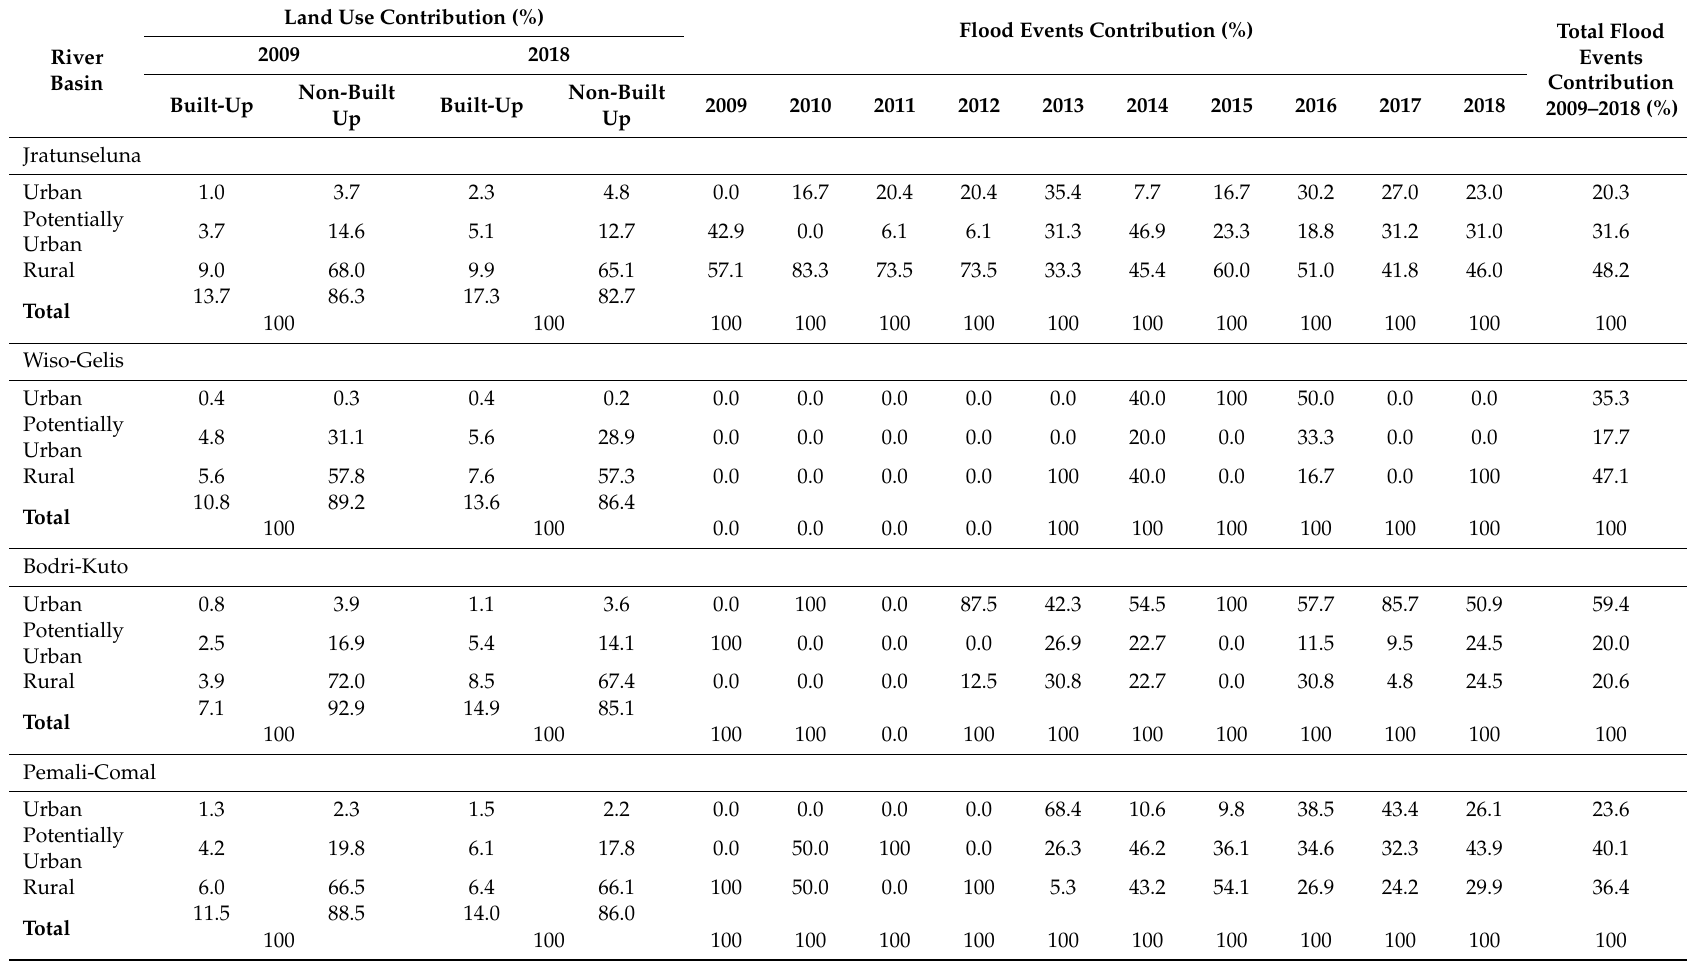
Table 7. Contribution of Land Use and Flood Events in the Study